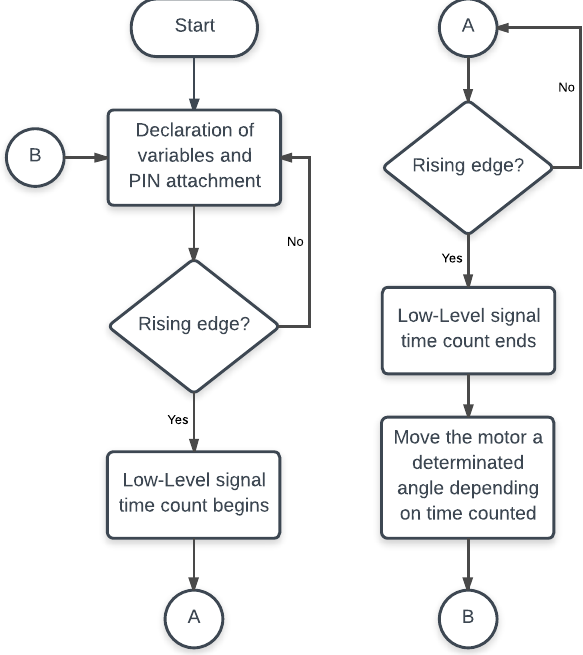
Figure 5. Flow chart of the firmware. The microcontroller sends an interruption for every rising edge detected in a declared pin. It starts counting the time when the signal is low-level, and compares this counter with the feedback of the potentiometer. In the case there is a difference, the motor is moved towards the set position.